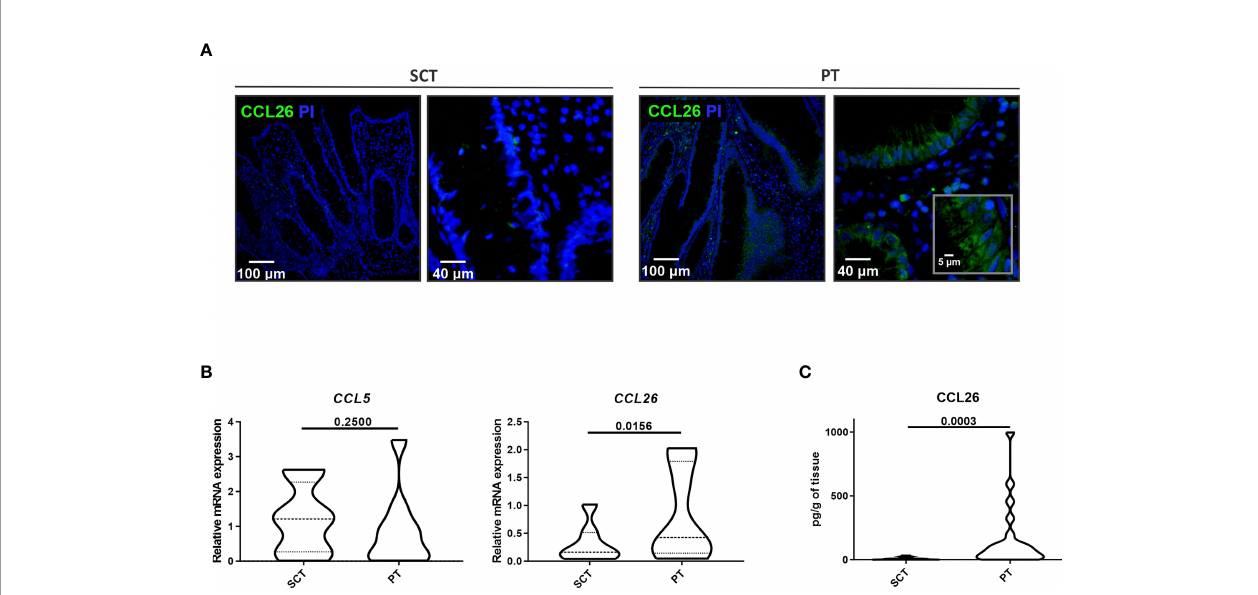
FIGURE 3 | Analysis of CCL26 production in colonic tissues. (A) CCL26 production was analyzed by confocal microscopy (DAPI was used for nucleus staining). The epithelial compartment showing CCL26 cytosolic expression is magni fi ed. (B) CCL5 and CCL26 expression measured by RT-qPCR was analyzed in colonic tissues. (C) The CCL26 tissue level was quanti fi ed by ELISA. Data are expressed as the mean value ± SEM. Statistic differences were calculated using Student´s t